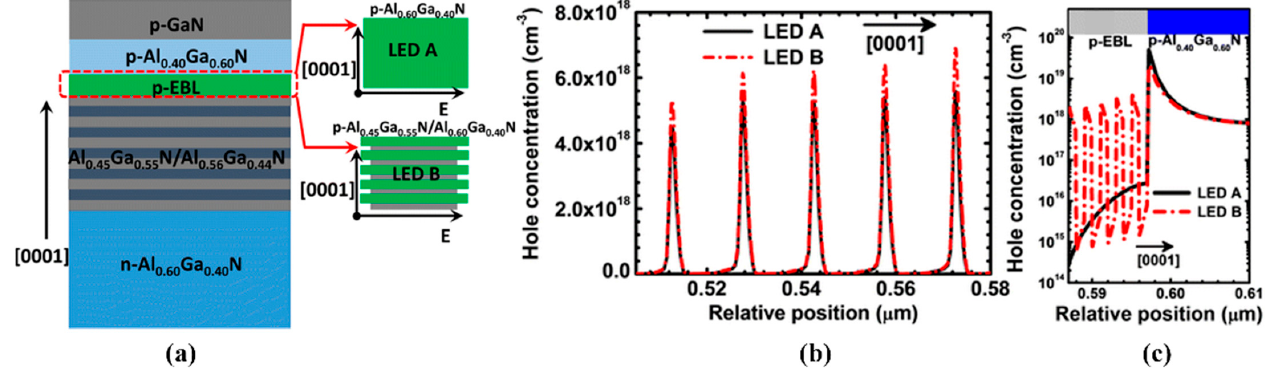
Figure 1. ( a ) Schematic structures for DUV LEDs with p-Al 0.60 Ga 0.40 N EBL (LED A) and p- Al 0.60 Ga 0.40 N/p-Al 0.45 Ga 0.55 N superla tt ice EBL (LED B). Numerically calculated hole concentration pro fi les ( b ) in the MQWs, ( c ) in the p-EBLs and p-Al 0.40 Ga 0.60 N layers for LEDs A and B. Reproduced from Ref. [45] with permission from Springer.